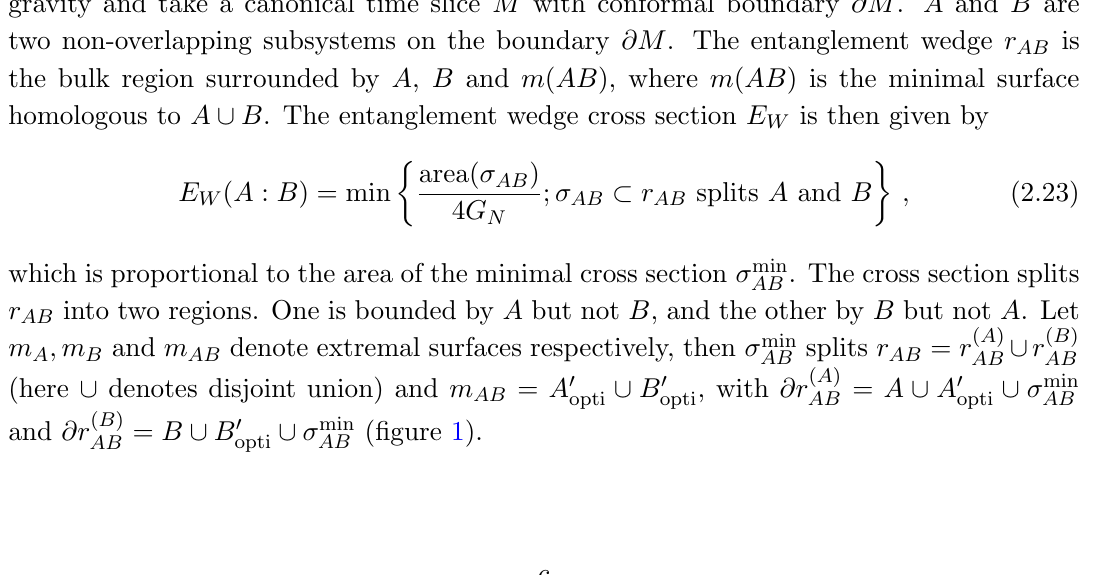
and B 0 , and (cid:27) min denotes the opti opti AB